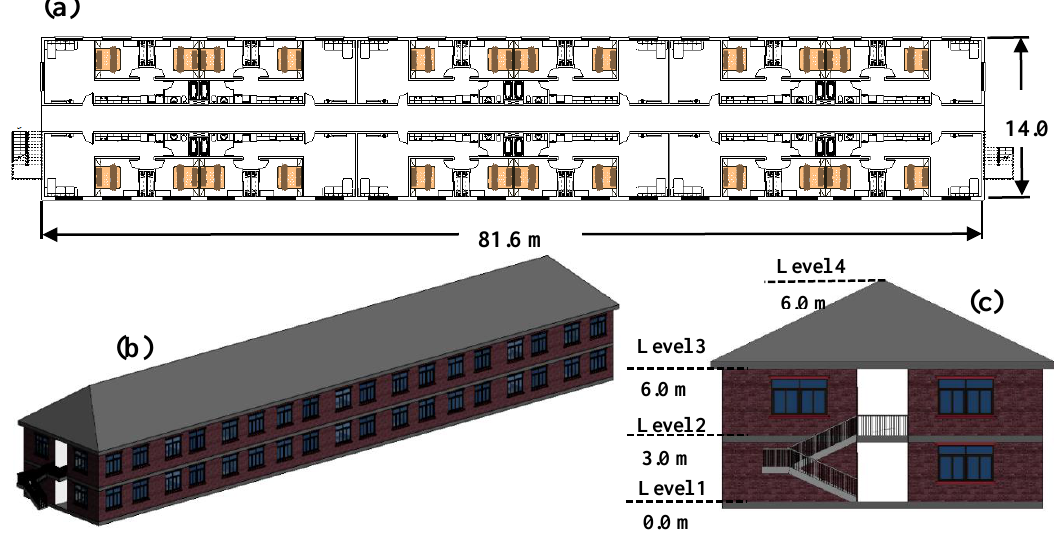
Figure A4. F4 archetype plans and sections: ( a ) Plan view; ( b ) 3-D view; ( c ) Side view.